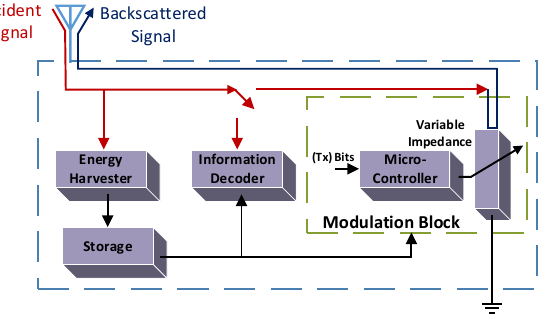
Figure 6. Architecture of the BackCom